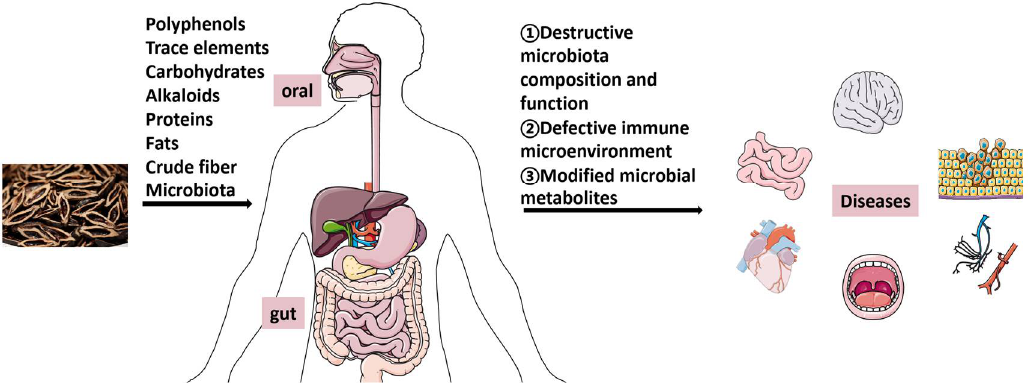
Figure 1. The major constituents of areca nut-induced dysbiosis of microbiome and its possible role in different diseases.